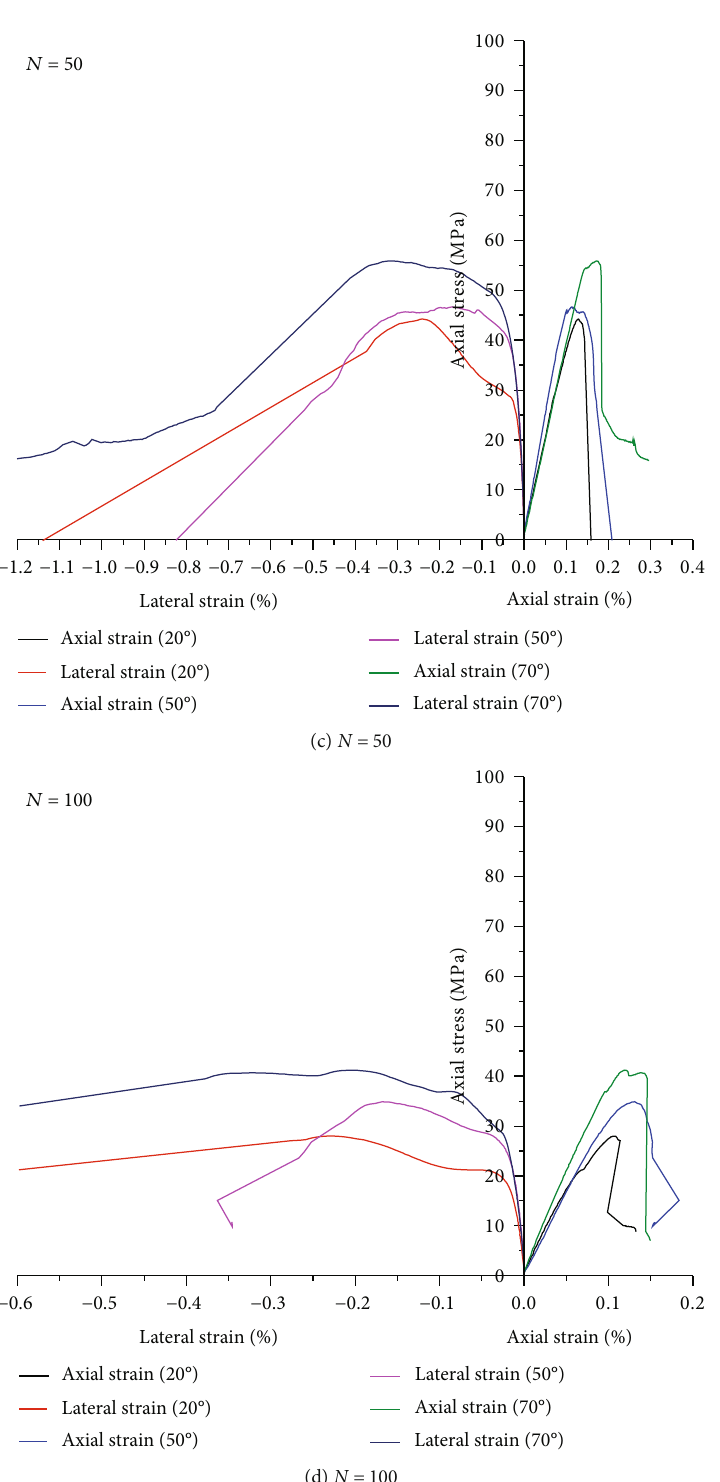
Figure 7: The typical axial and lateral stress – strain curves for the samples containing two fl aws. (a – d) The number of F-T cycles is 0, 20, 50, and 70,